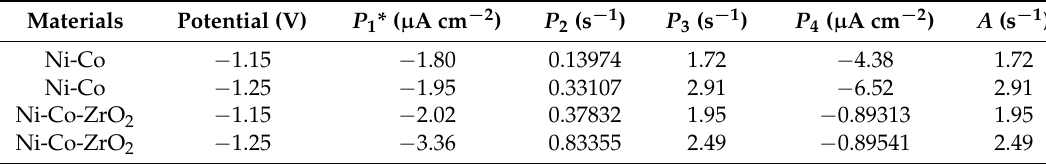
Figure 5. Nonlinear fitting curves for experimental transient curves by use of Equation (5) ( a ) Ni-Co layer and ( b ) Ni-Co-ZrO 2 composite deposition, potential range at − 1.15 V and − 1.25 V, ultrasonic power 100 W, T = 40 °C and pH = 4. Table 2. Optimal nucleation kinetic parameters derived from Equation